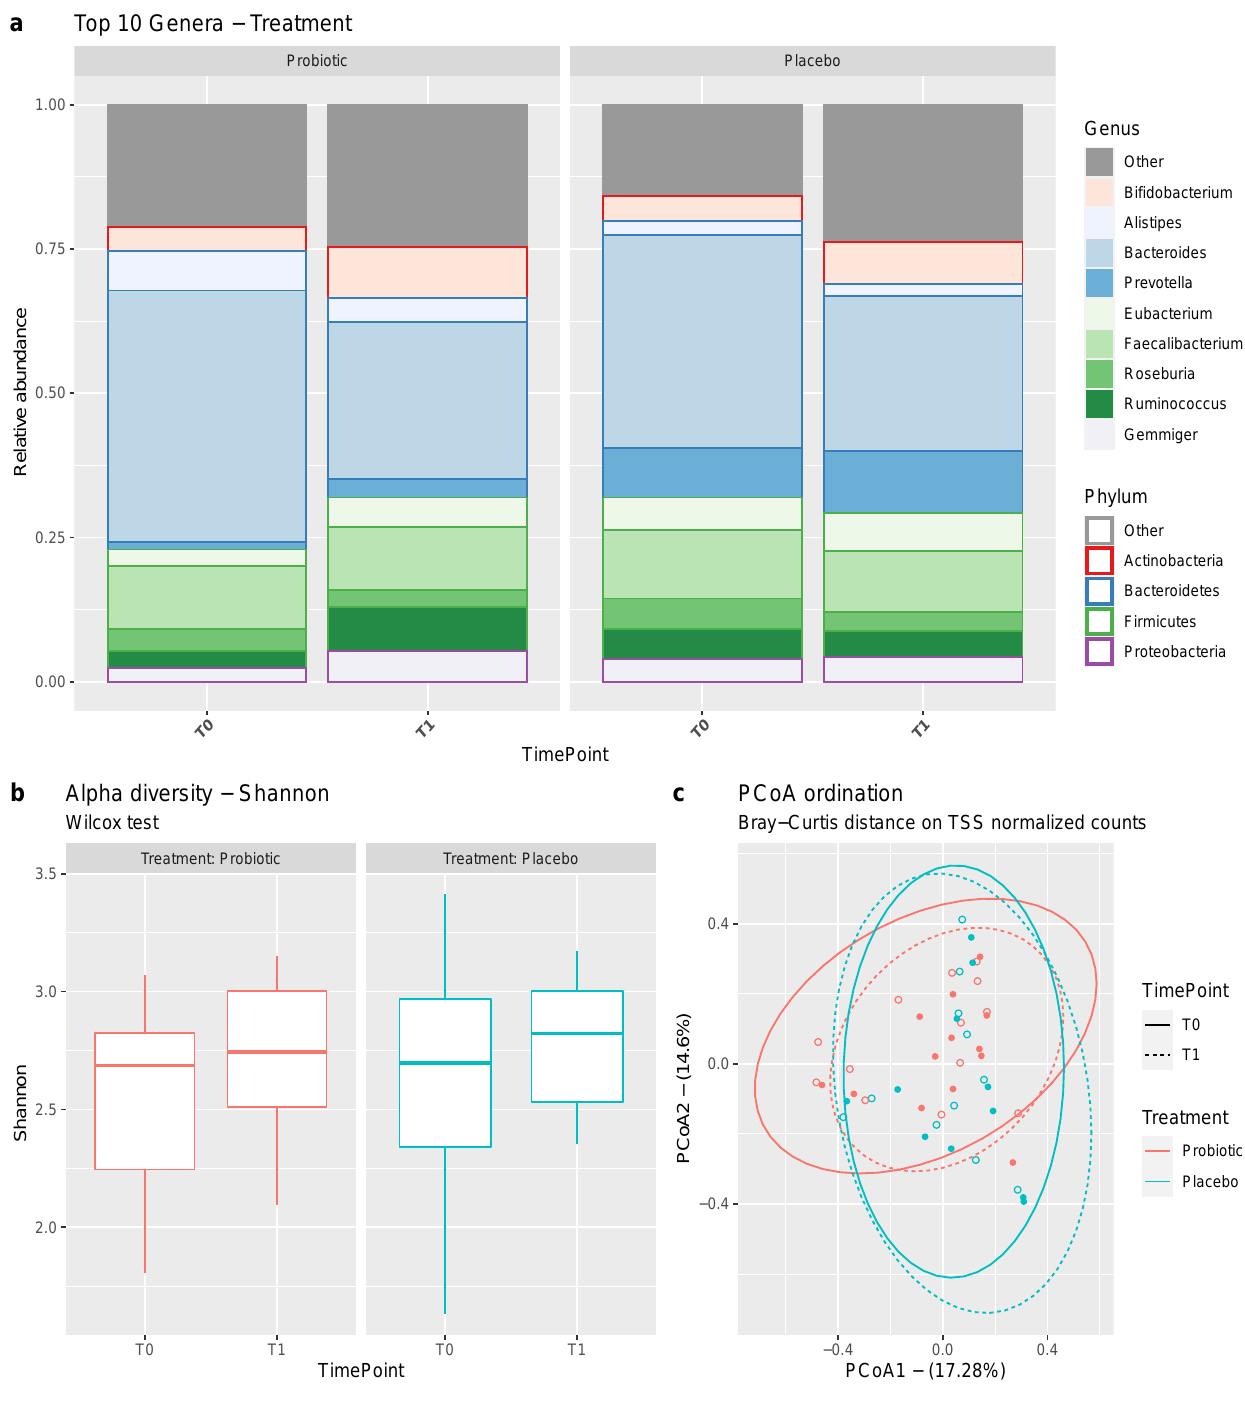
Figure 3. ( a ) The top 10 genera and related phyla of membership. Genera are plotted for their mean relative abundance over time point, faceted by treatment arm. ( b ) Shannon–Wiener α -diversity, over time point and faceted by treatment arm. ( c ) β -diversity bidimensional representation (PCoA ordination method on the Bray–Curtis distance matrix of TSS normalized counts). Colored by treatment arm and shaped by time